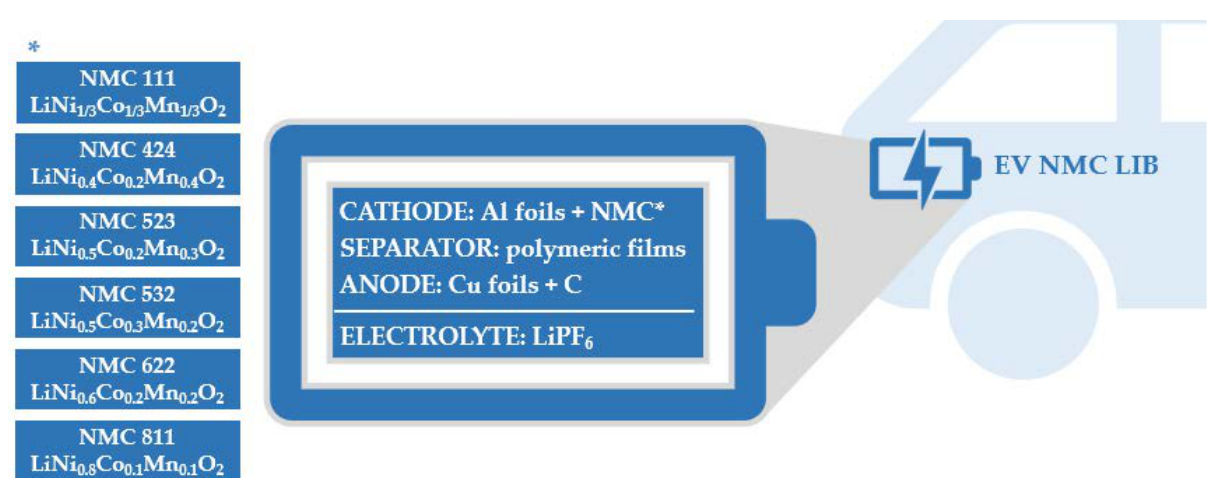
Figure 1. Composition of a general NMC LIB cell. (* it complements individual NMC cell chemis- tries.